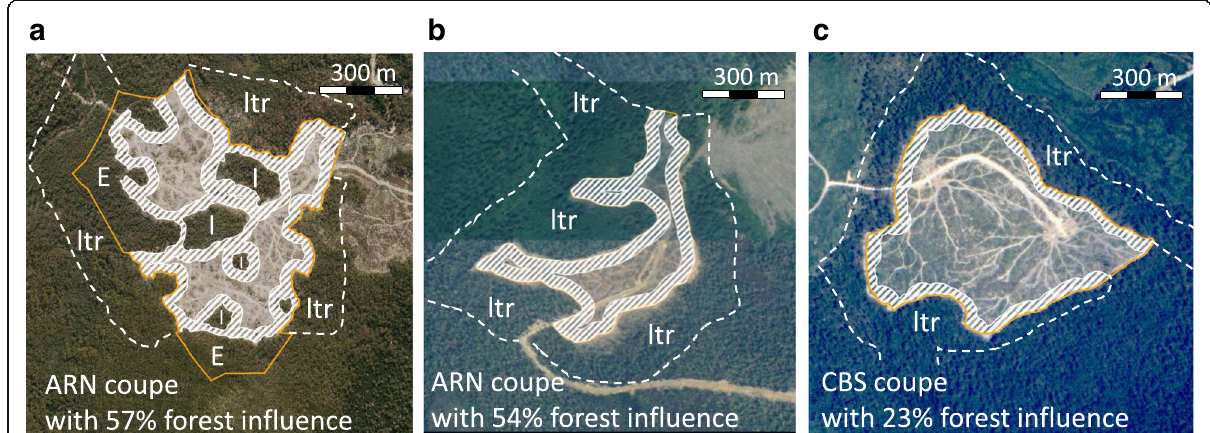
Fig. 1 An overhead aerial view of two aggregated retention (ARN) coupes ( a , b ) and a clearfell, burn and sow (CBS) coupe ( c ), showing the area under forest influence. The yellow line indicates the coupe boundary (i.e., the area available for harvest), while the diagonal lines show the portion of the harvested area within one tree height of retained standing forest. Also marked are edge aggregates (E), island aggregates (I), and long-term retention outside of the coupe (ltr, delineated by dashed lines). The ARN coupe in a has 44% retention in edge and island aggregates within the coupe boundary, while the ARN coupe in b has 0% retention within the coupe because conservation objectives are achieved by the long-term retention outside the